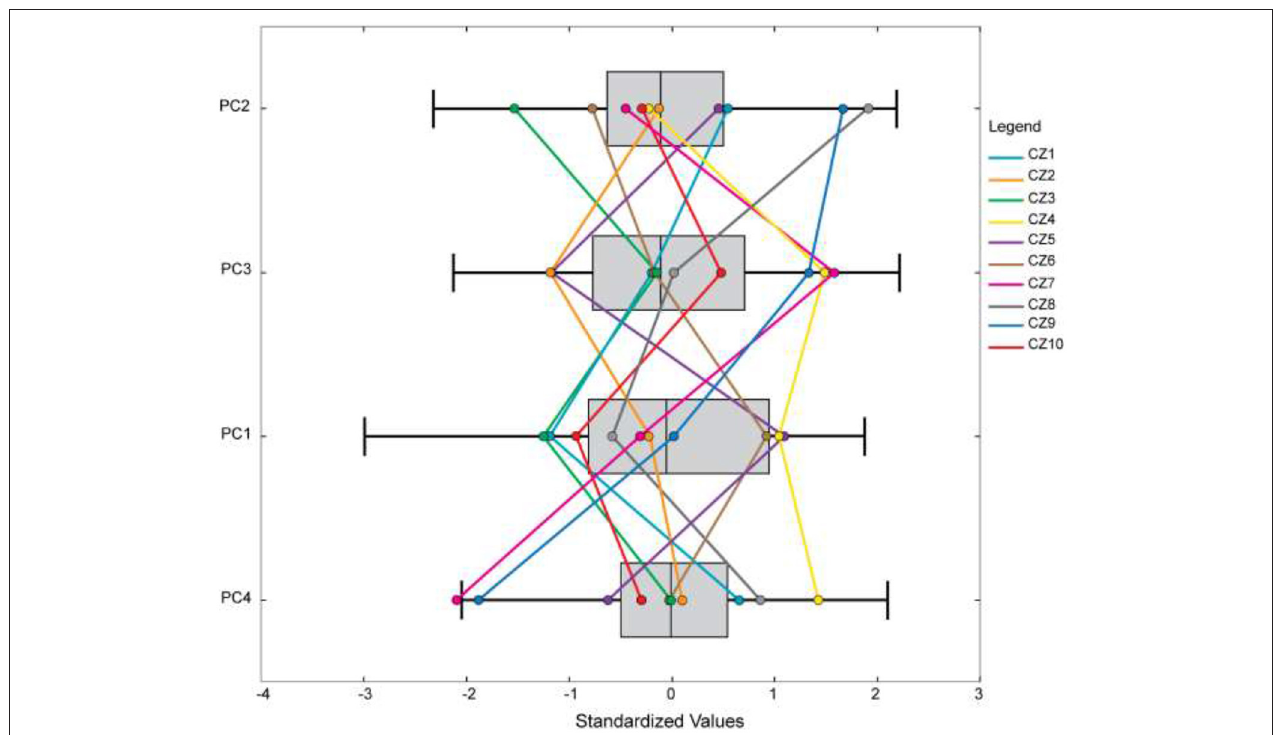
FIGURE 6 | Parallel box plot of four principal